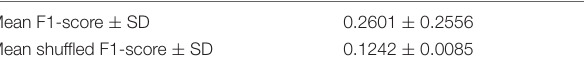
TABLE 2 | Decoding performance across the population of thalamic neurons, compared with shuffled data.